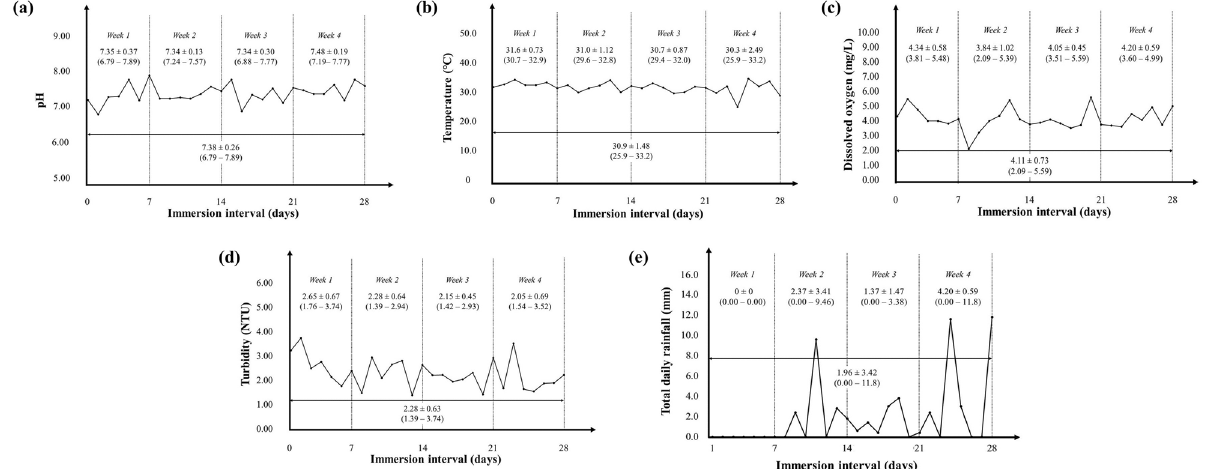
Figure 2. The overall ( a ) pH, ( b ) temperature, ( c ) dissolved oxygen and ( d ) turbidity of the natural outdoor pond water as well as its ( e ) total daily rainfall throughout the four weeks of observation. The data are presented as mean ± standard deviation with values in parentheses () indicate the